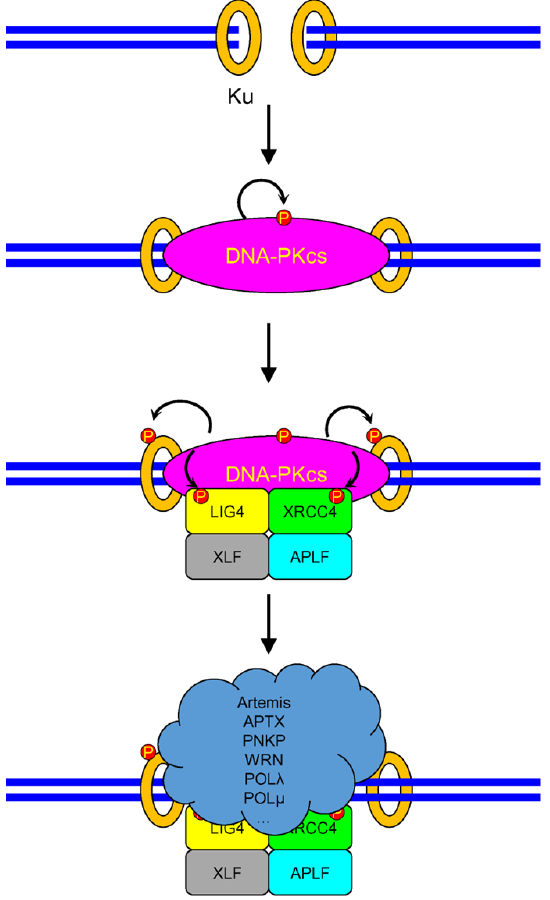
Figure 5. Principal scheme of non-homologous end joining in human cells. DSB ends are recognized by Ku, followed by DNA-PKcs binding and self-phosphorylation (red circles). This promotes the binding of LIG4/XRCC4, XLF, and APLF. After Ku and LIG4/XRCC4 phosphorylation, DNA-PKcs